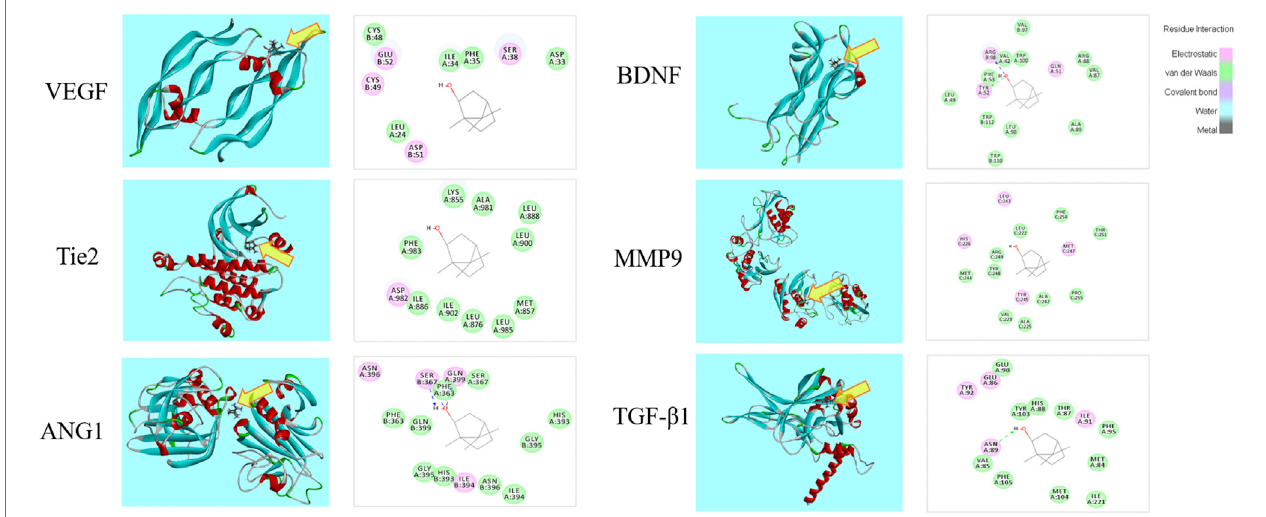
FIGURE 11 | Graph of the small molecule and the target